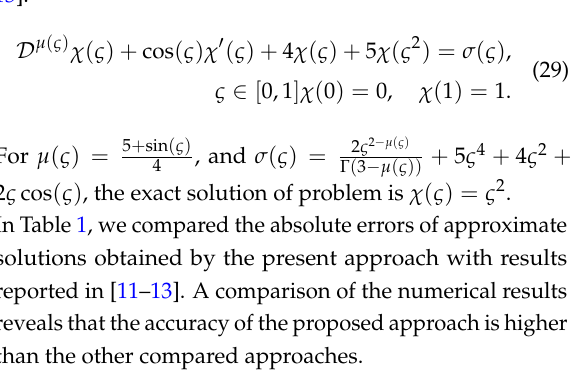
Fig. 3. Absolute errors of the approximate solution of problem (32) for Λ =